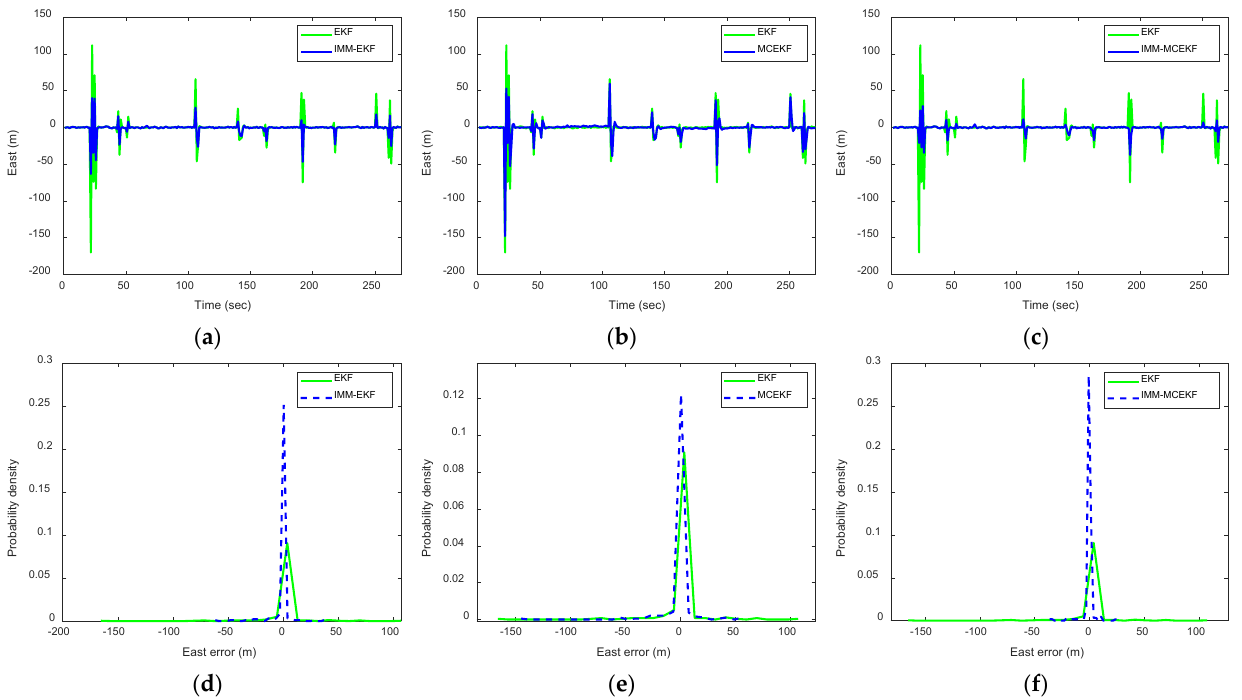
Figure 7. Comparison between the navigational accuracy and the corresponding probability density functions (pdfs) of the east position errors: ( top ) navigational accuracies for EKF vs. ( a ) IMM–EKF, ( b ) MCEKF, and ( c ) IMM–MCEKF, and ( bottom ) pdfs of position errors for EKF vs. ( d ) IMM–EKF, ( e ) MCEKF, and ( f ) IMM–MCEKF.